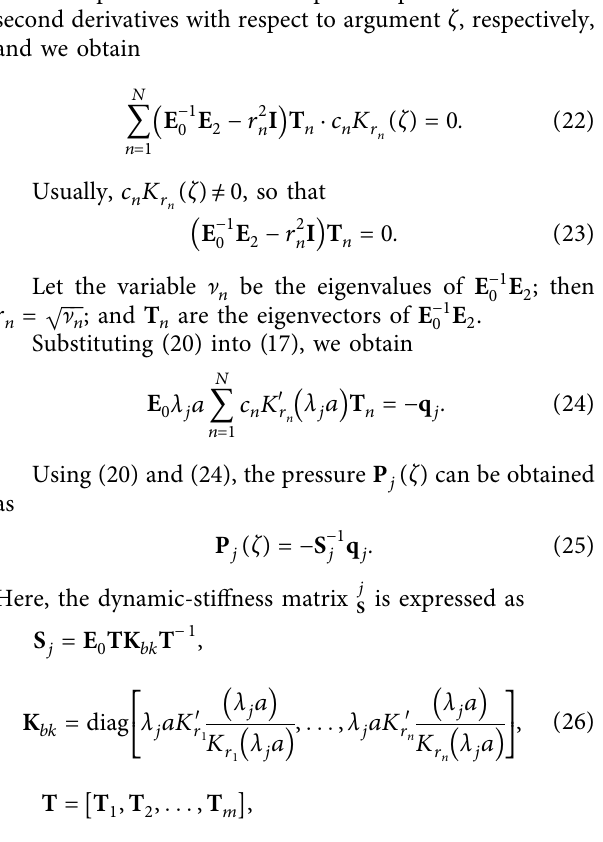
s / ω 0 with respect to � 0. with δ 0 0